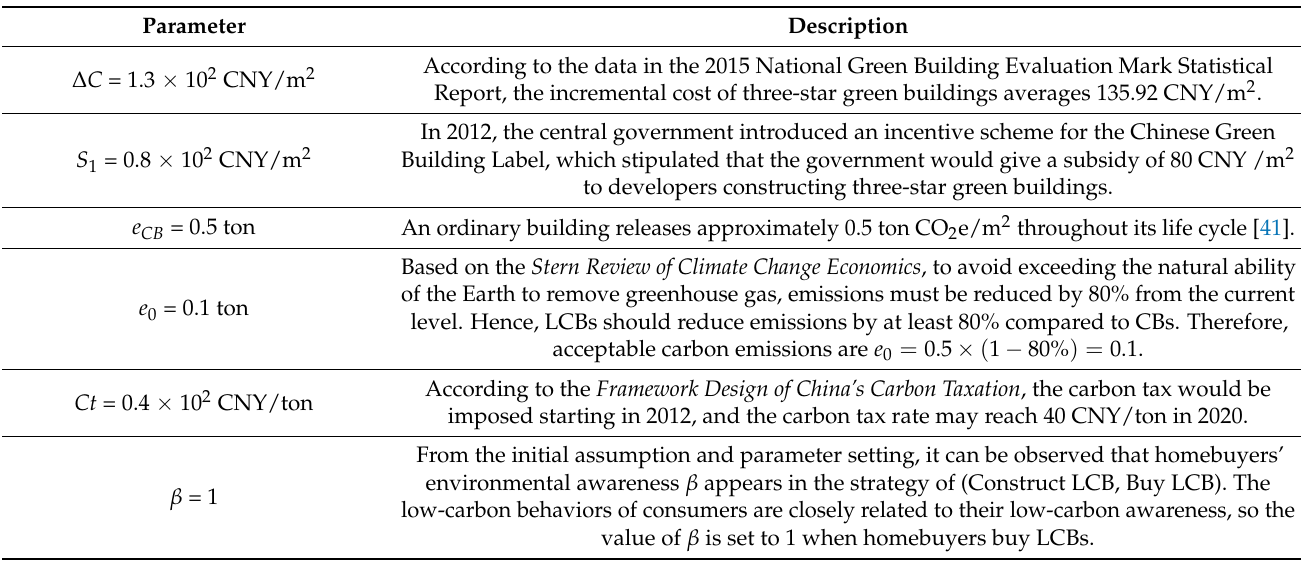
Table 6. Initial values of the parameters and